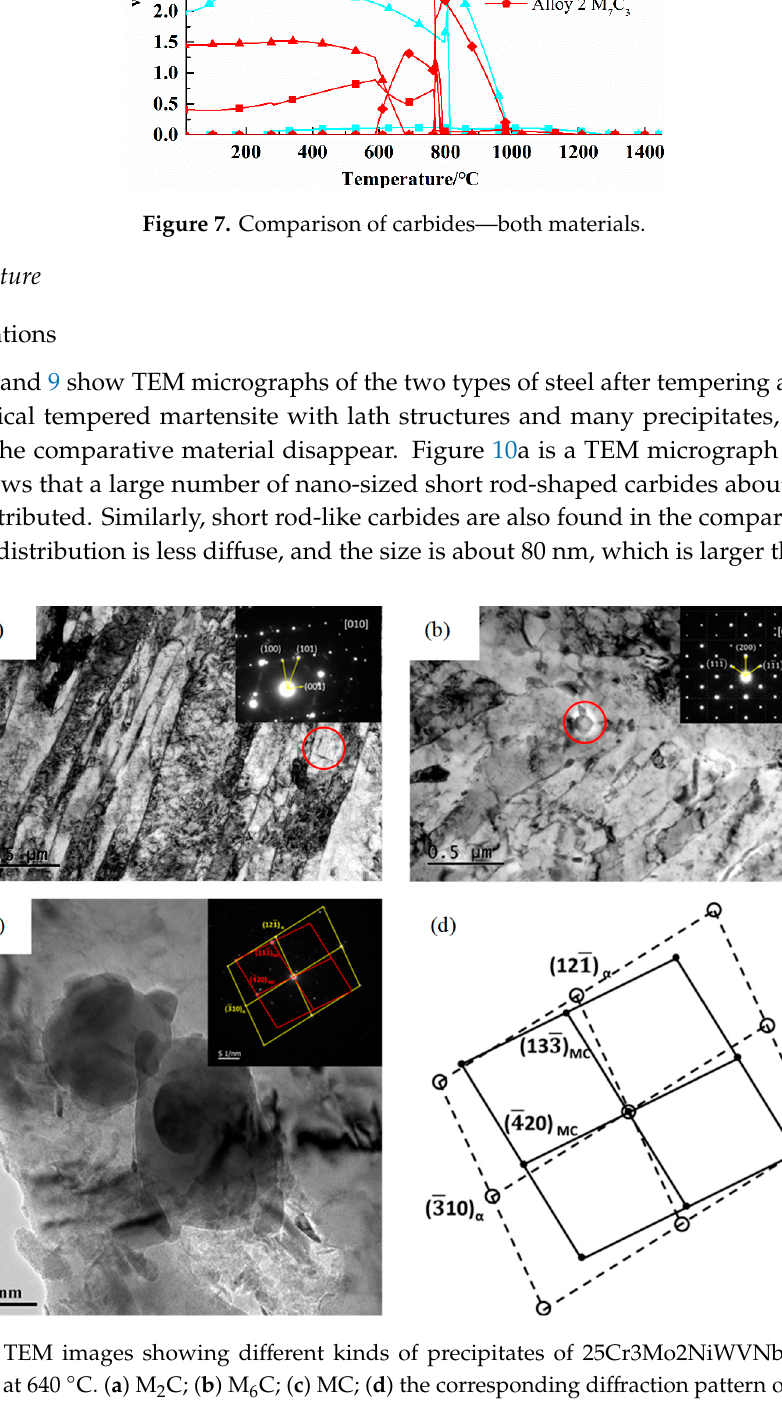
Figure 9. TEM micrographs of two kinds of precipitates in 25Cr3Mo3NiNb steel after tempering at 640 °C.